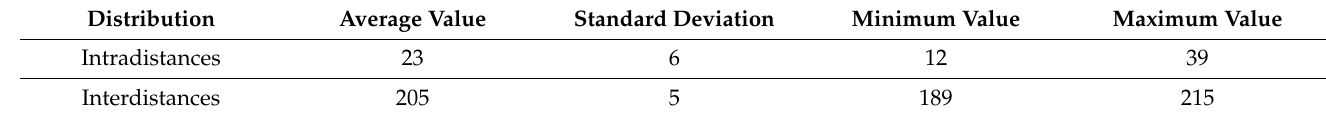
Figure 12. Histograms of the distance distribution between bit templates of one device (intradis- tances) and two devices (interdistances).